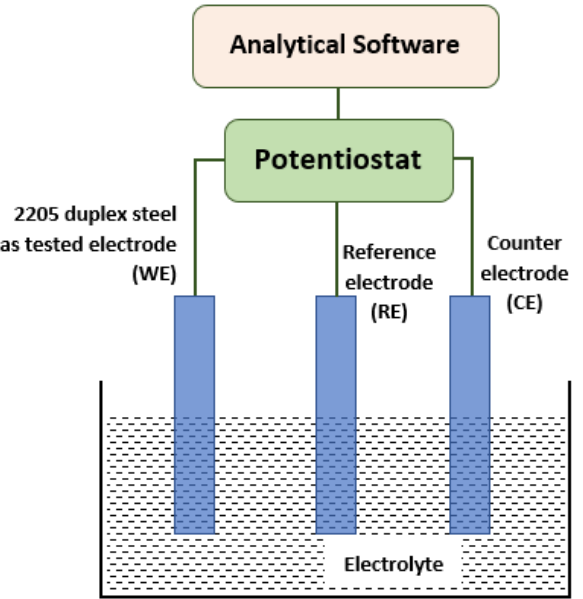
Figure 1. Schematic representation of the set-up for electrochemical studies.